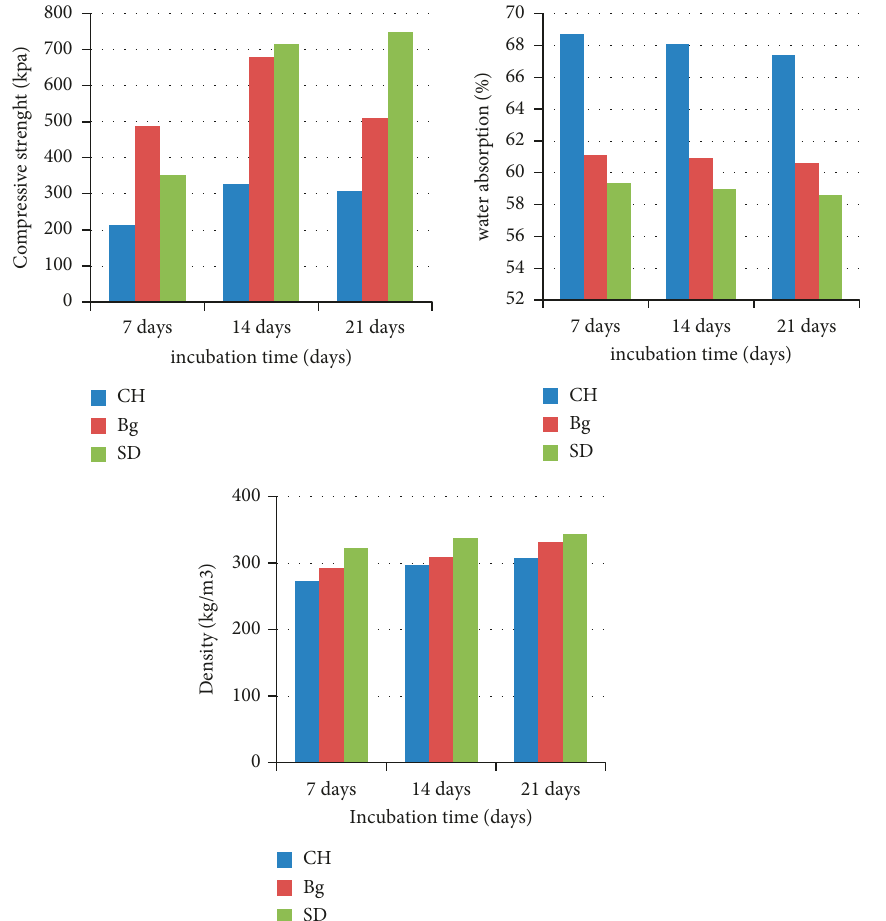
Figure 8: Mycoblock physical and mechanical characteristics with varying substrates and incubation